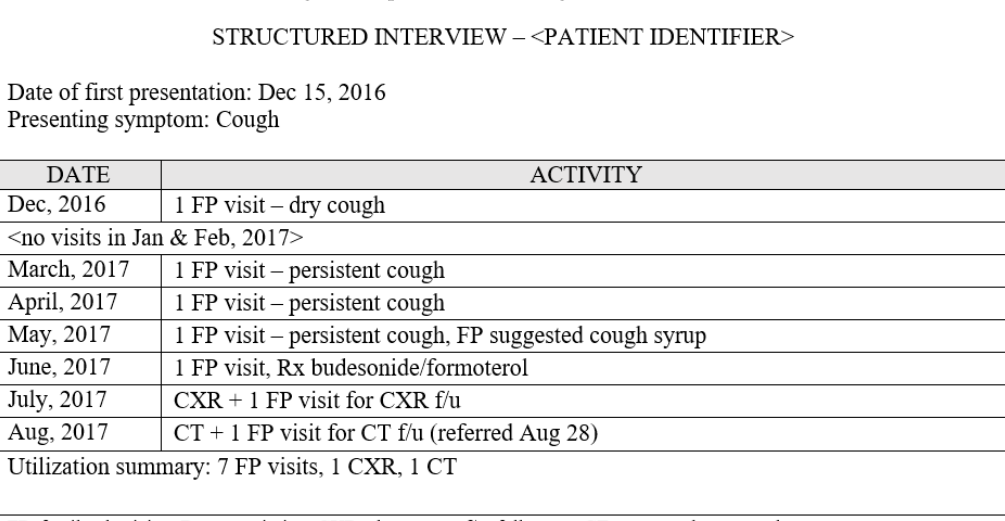
Figure 2. Cue card given to patients and caregivers in advance of the interview.